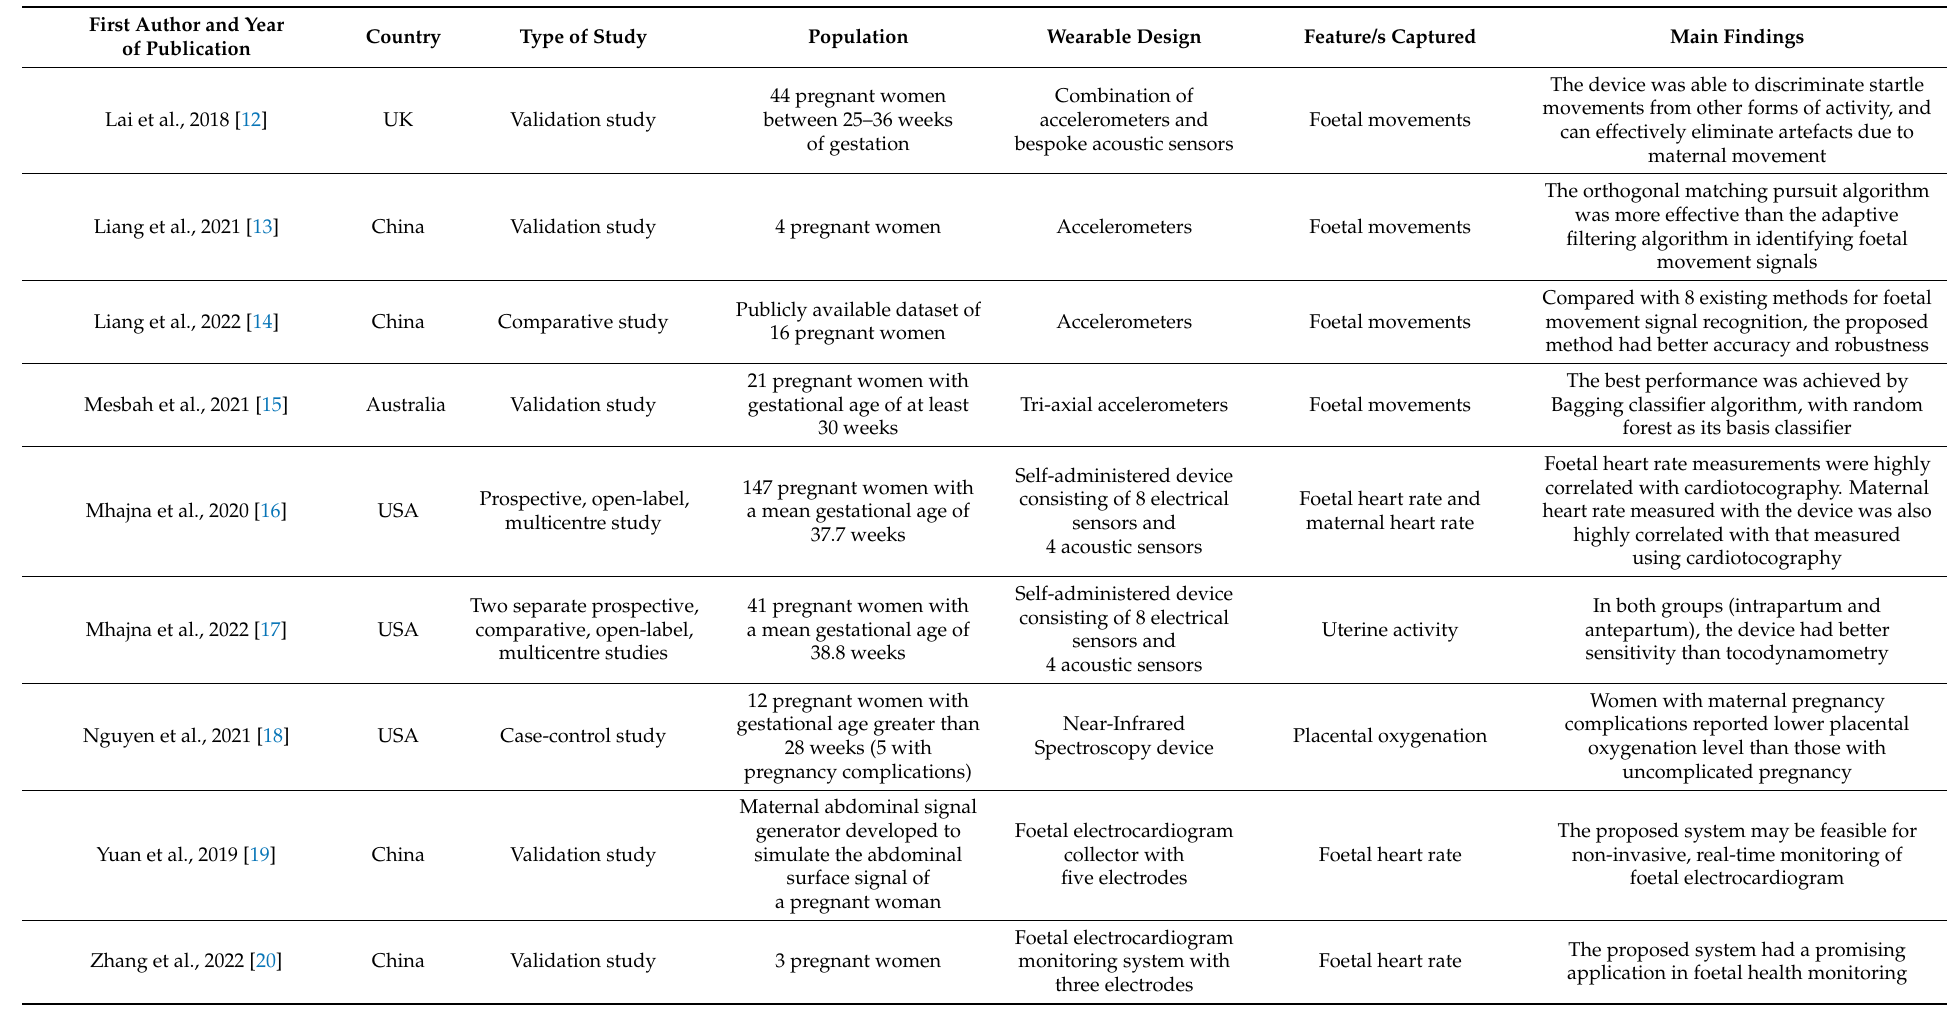
Table 1. Characteristics of studies using wearable devices for foetal characteristics and